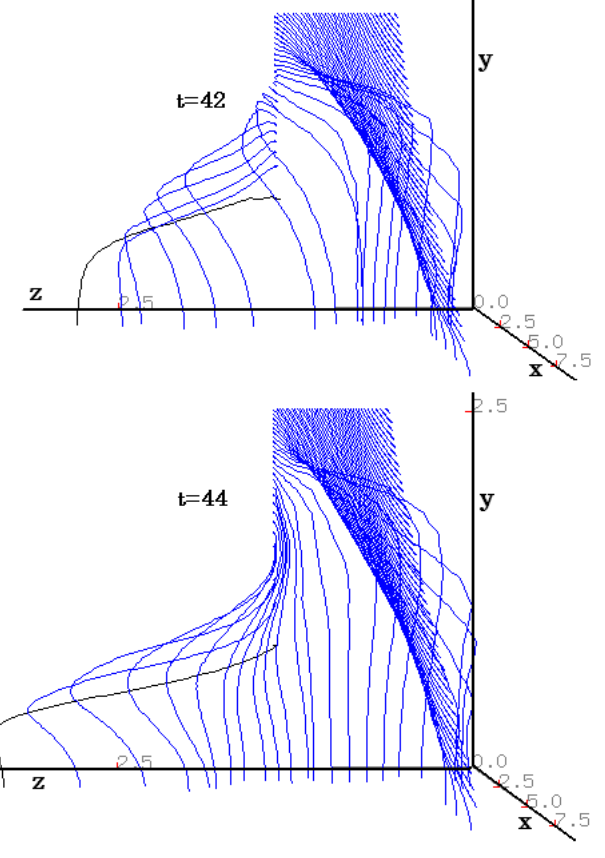
Fig. 12. Magnetic field lines that pass through the spatial points on the y -directional line at x = 0 and z = 1 . 5.